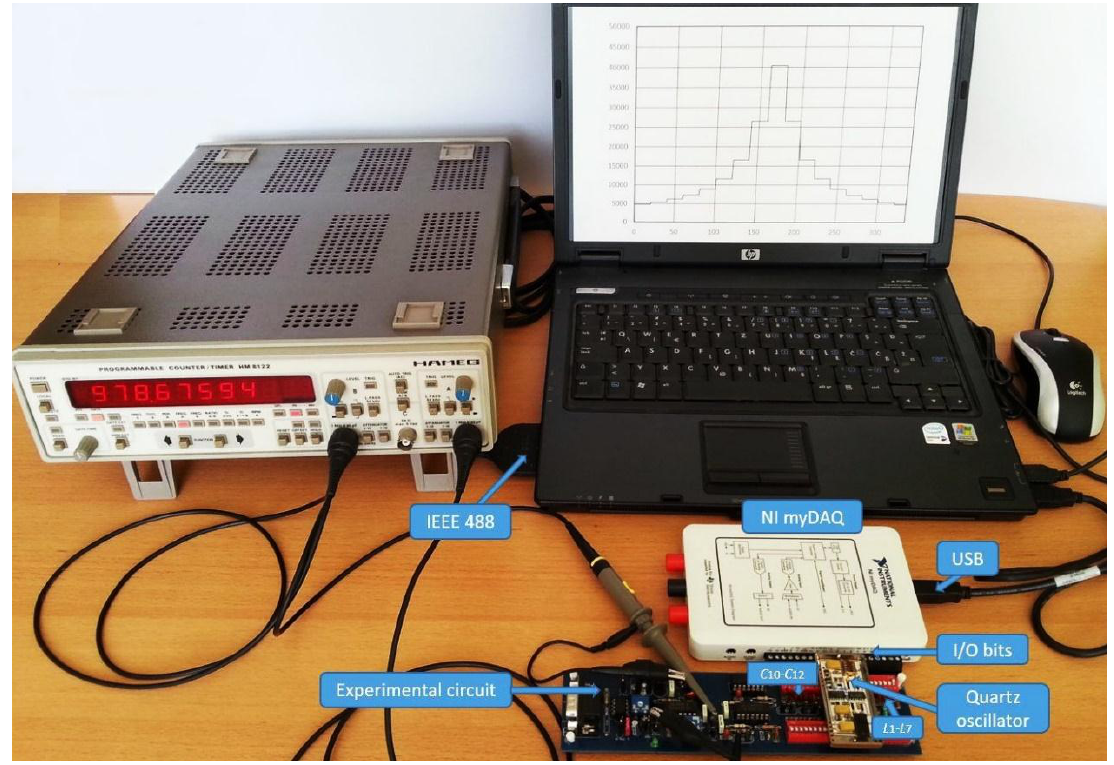
Figure 4. Experimental setup with experimental switching circuit.